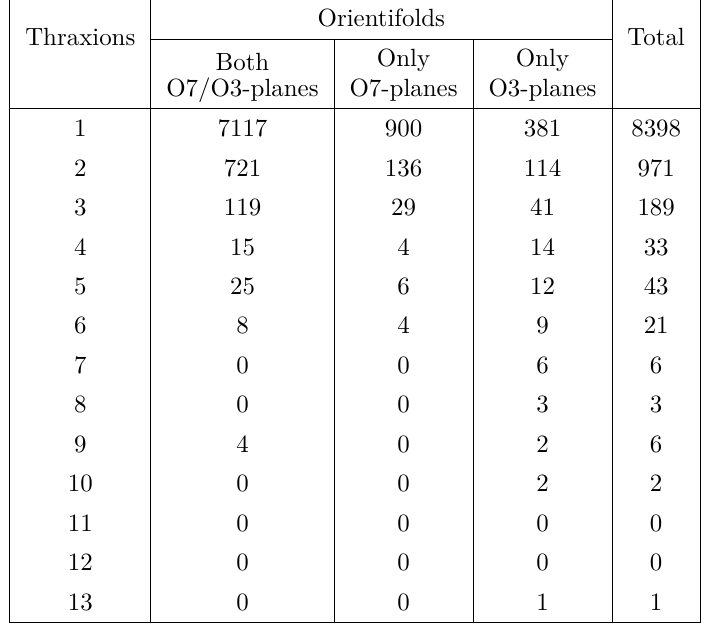
Table 4 . Number of CICY orientifolds in M 1 divided by the number of thraxions and kind of orientifolds they